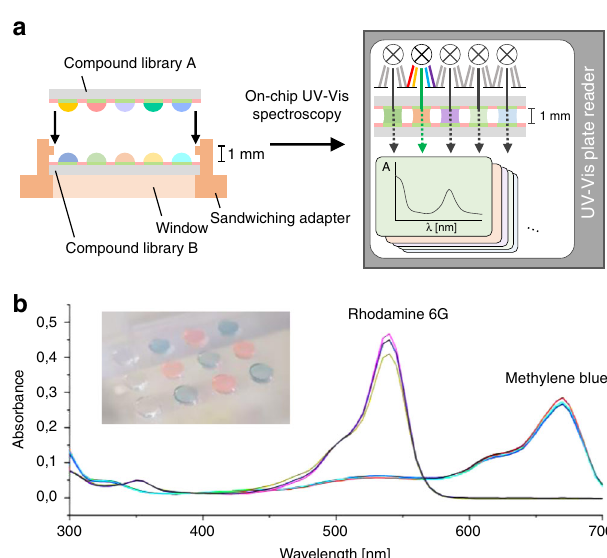
Fig. 5 On-chip characterization by UV – Vis spectroscopy. a Schematic diagram showing the process of on-chip UV – Vis spectroscopy. Droplets can be trapped between two slides sandwiched within a distance of 1 mm in a 3D-printed adapter. On-chip UV – Vis absorbance can be measured using commercial plate readers. b On-chip measured UV – Vis spectra of rhodamine 6 G and methylene blue applied on-chip in a checkerboard pattern and trapped between two dendrimer slides. Source data are provided as a Source Data fi